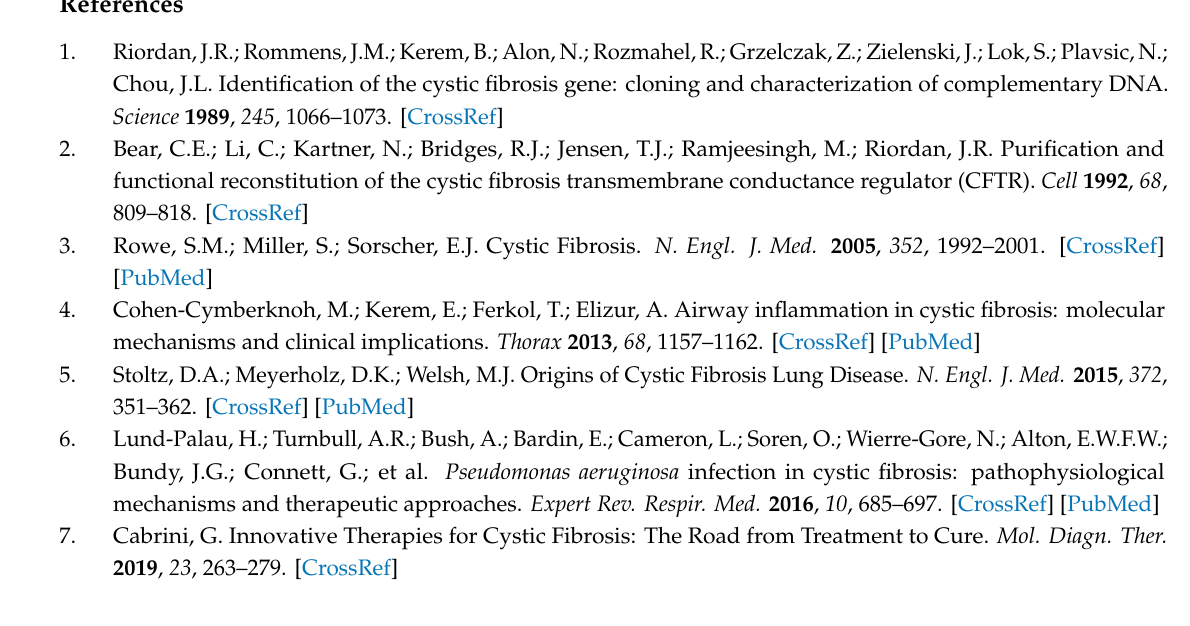
Figure S1: Normalized P. aeruginosa growth in media and atop HBE